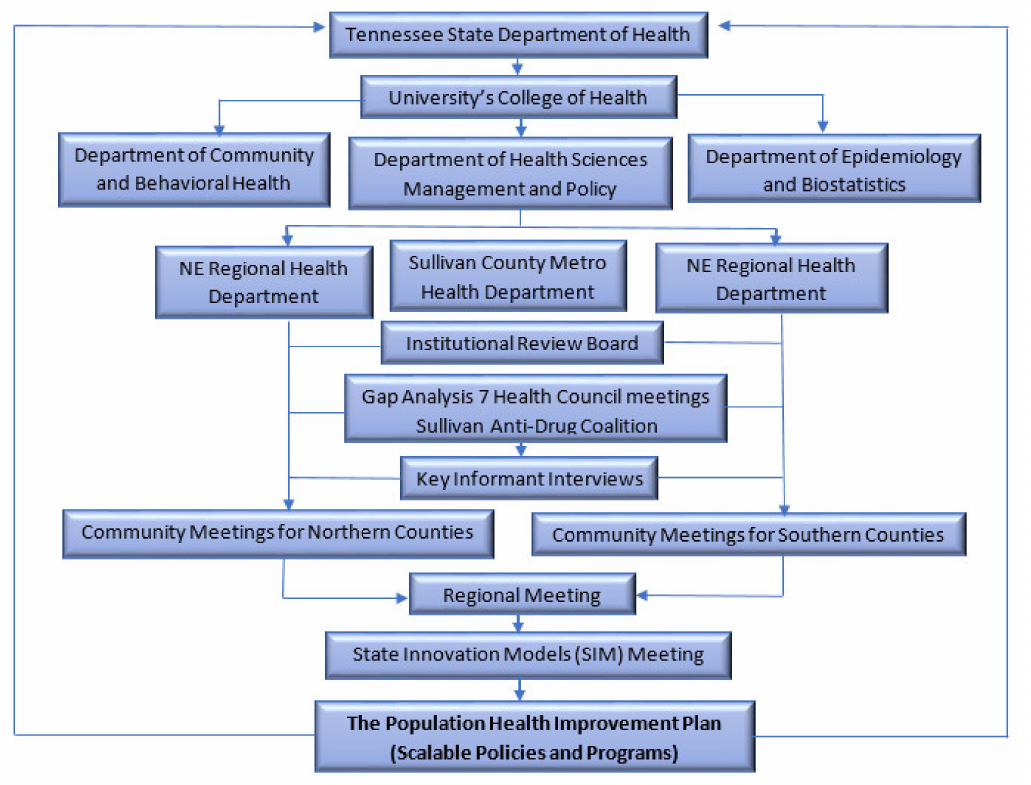
Figure 1. The Population Health Improvement Plan (PHIP) Project